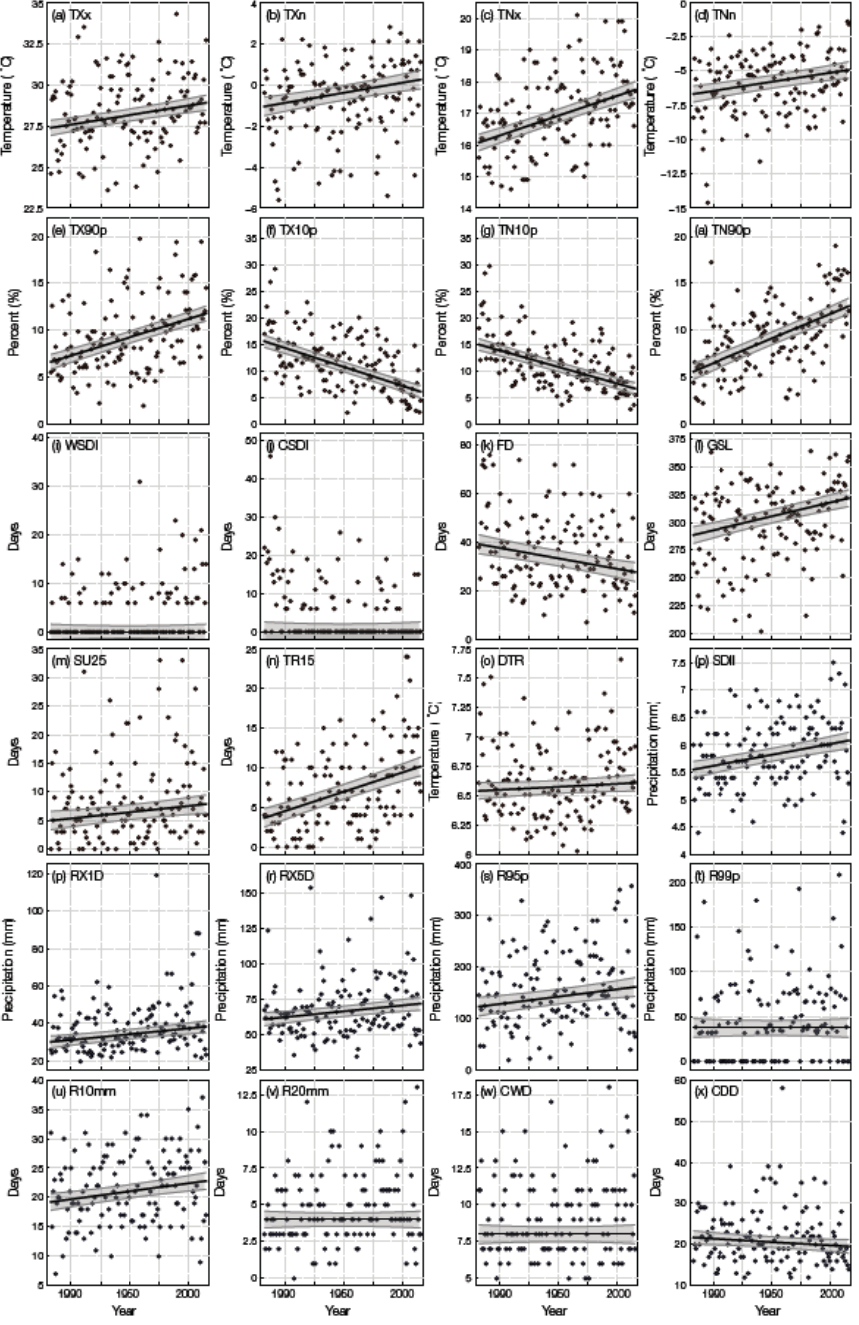
Figure 4. The annual evolution of ( a – x ) 24 extreme indices for WP. Solid lines are Theil-Sen trends for the period 1883–2015 with 95% confidence intervals (accounting for autocorrelation) in grey shading.